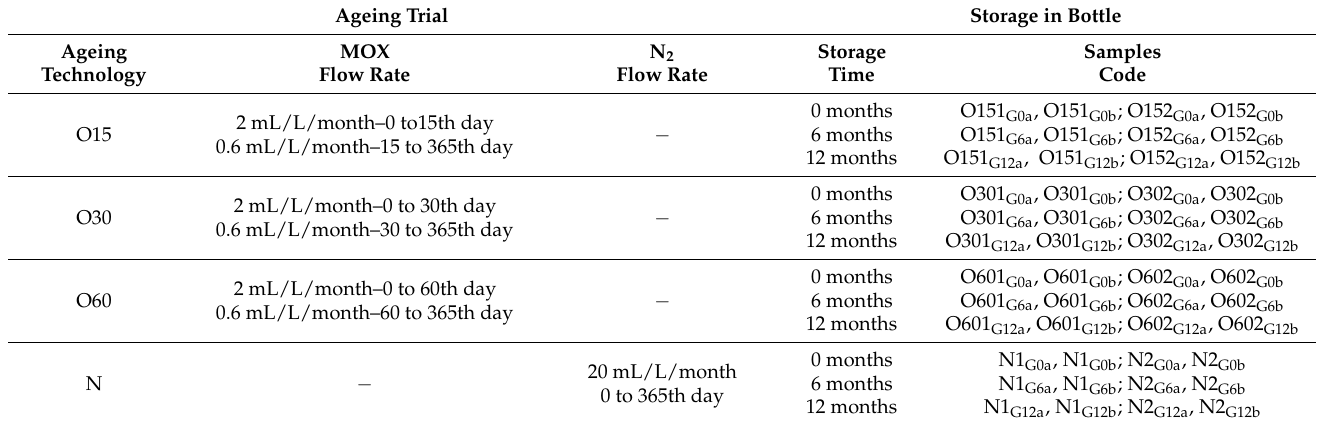
Table 4. Description of each ageing technology and the storage in bottle. Ageing Trial Storage in